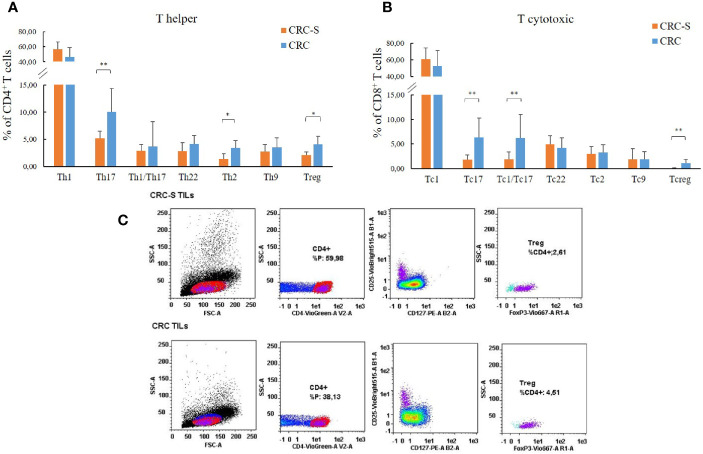
T cell subset distribution in the tumor mucosa and surrounding healthy mucosa samples groups. Panel (A) reports the mean percentages (+SD) of T helper subsets with respect to the percentage of CD4+ T cells, and panel (B) reports the mean percentages (+SD) of T cytotoxic subsets with respect to the percentage of CD8+ T cells. Panel (C) reports the cytofluorimetric analysis of T regulatory cells in the tumor mucosa and surrounding healthy mucosa samples of one representative patient. Statistical analyses were calculated using Wilcoxon signed-rank test. The asterisks (*) represent p-values, *p < 0.01, **p < 0.001. CRC = tumor mucosa; CRC-S = healthy mucosa.